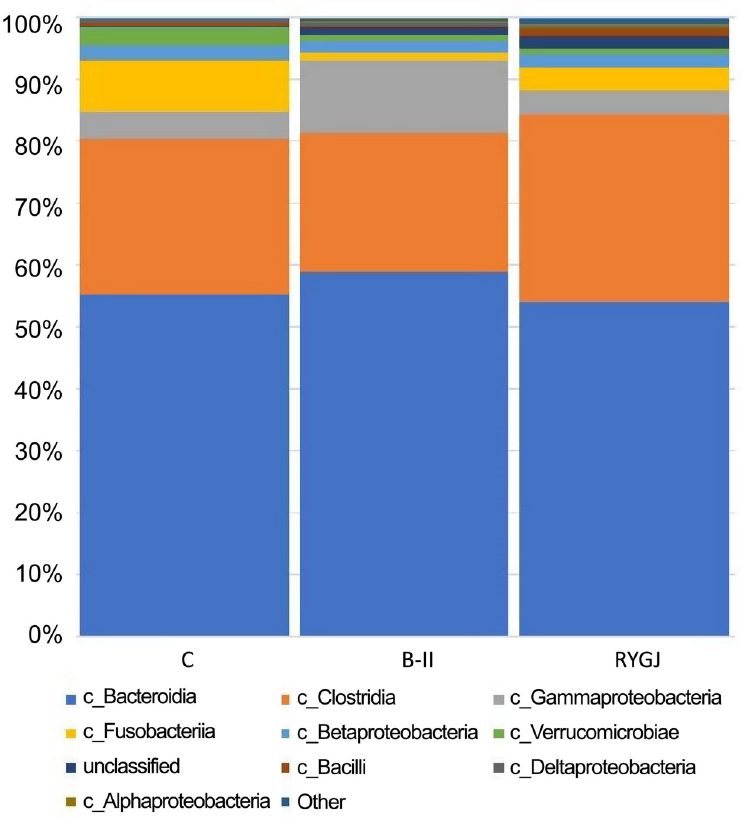
Fig 3. Relative abundances of classes across three groups. C, control; B-II, subtotal gastrectomy with Billroth II anastomosis; RYGJ, subtotal gastrectomy with Roux-en-Y gastrojejunal anastomosis.